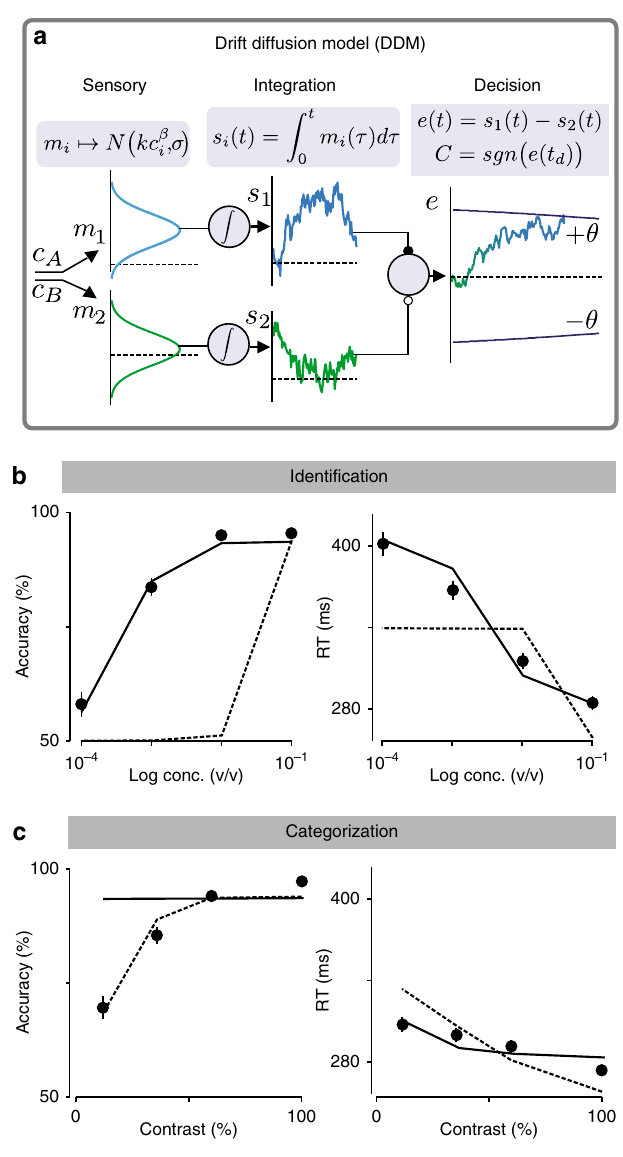
Fig. 3 Failure to simultaneously fi t performance on identi fi cation and categorization tasks with Drift-diffusion model. a Drift-diffusion model (DDM). The model consists of three layers — sensory, integration and decision layer. At the sensory layer, concentrations are transformed into rates that are contaminated with Gaussian noise. These rates are then integrated over time (integration layer) and combined. Note that the choice of weights ( − 1 and 1) for the decision layer allows it to effectively be a DDM with collapsing bounds. This model presents 7 parameters (Methods). b Fitting results for accuracy and reaction time in identi fi cation task. Black solid line represents the model fi t for this data, and dashed lines the prediction from the categorization data fi t. c Fitting results for accuracy and reaction time in categorization task. Solid black lines depict the prediction for this data from the model fi tted to identi fi cation, and dashed lines the DDM fi t for this data. Error bars are mean ± SEM over trials and